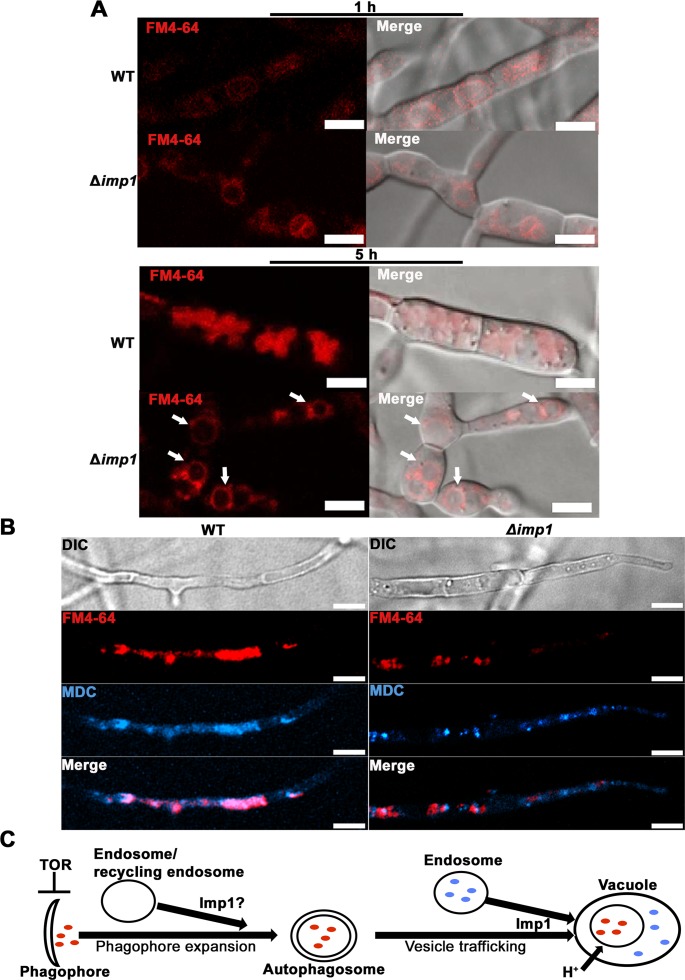
IMP1 mediates endocytic and autophagic vesicle dynamics.(A) FM4-64 staining shows endocytic vesicles targeting vacuoles in Δimp1 and WT. After 5h, FM4-64 is not distributed throughout the full vesicular network in Δimp1 mycelia. Scale bar = 2 μm. (B) Monodansylcadaverine (MDC) staining revealed both reduced numbers of autophagic vacuoles in Δimp1 compared to WT, and reduced overlap with FM4-64 stained compartments. Mycelia from WT and Δimp1 were incubated in GMM for 16 h then stained with 1 μg per ml FM4-64 and 40 μM MDC for 5 h in water. Scale bar = 10 μm. (C) IMP1 is required for endosomal and autophagosomal membrane vesicle trafficking to acidified autophagic vacuoles, and might also be required for supplying endosomal membranes for phagophore expansion.